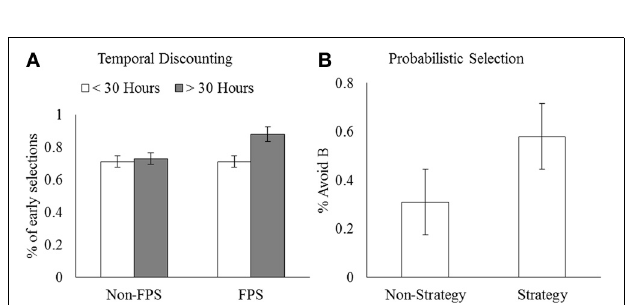
FIGURE 1 | (A) Mean proportion of early selections in the temporal discounting task as a function of Hours and identification as an FPS gamer. (B) Avoid B in the probabilistic selection task as a function of identification as a strategy gamer. Error bars represent standard error of the mean.